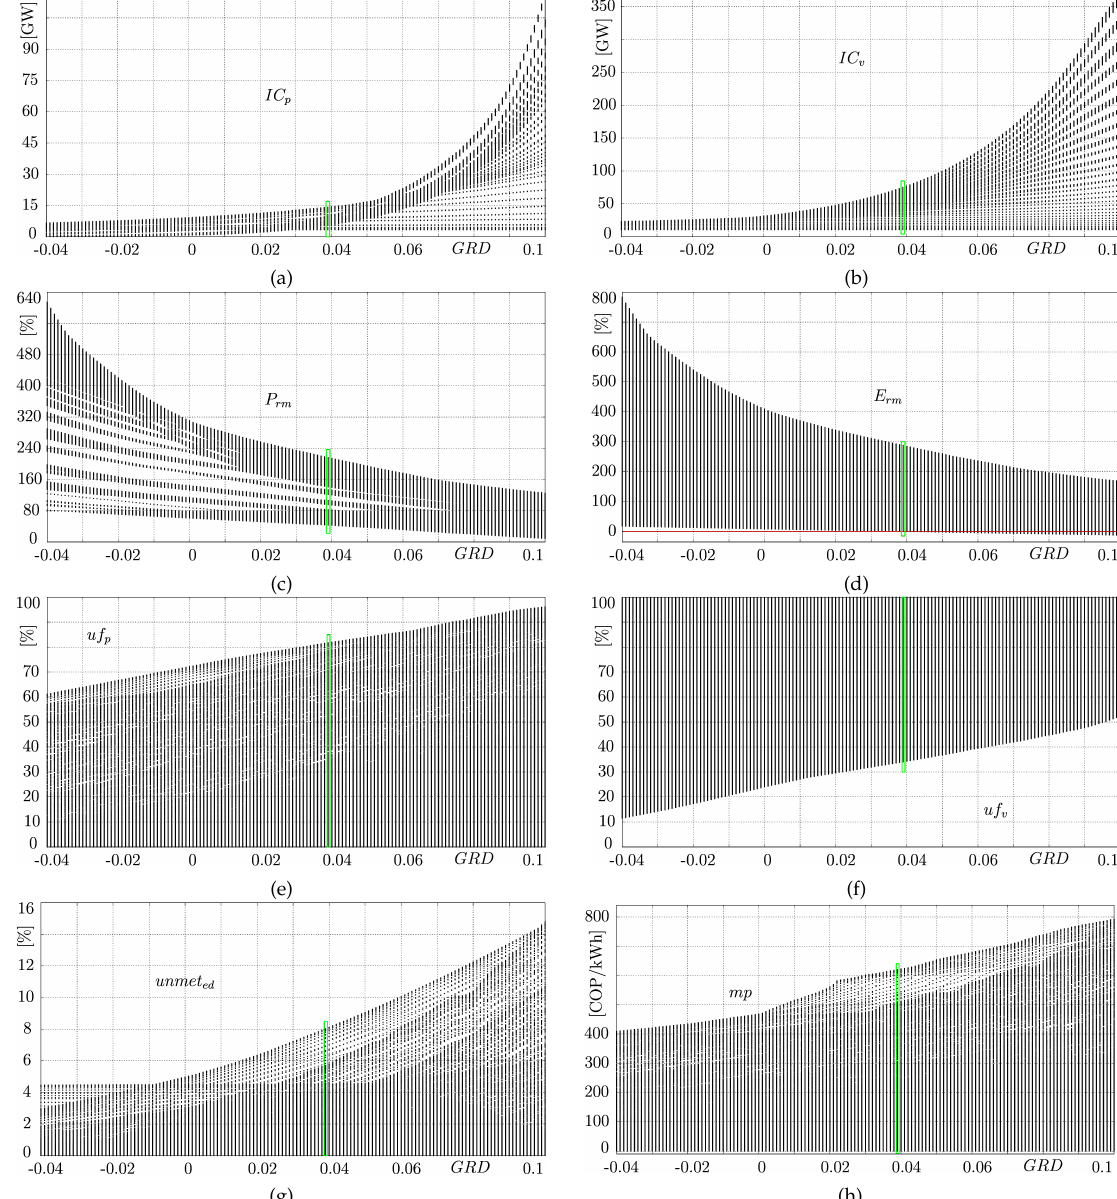
Figure 11. GRD scenarios under seasonality and ENSO phenomenon. GRD was varied from − 0.04 to 0.1. The green rectangles marked in all figures represent the current Colombian scenario ( GRD = 0.039) ( a ) IC p , ( b ) IC v , ( c ) P rm , ( d ) E rm , ( e ) uf p , ( f ) uf v , ( g ) unmet ed , and ( h ) mp